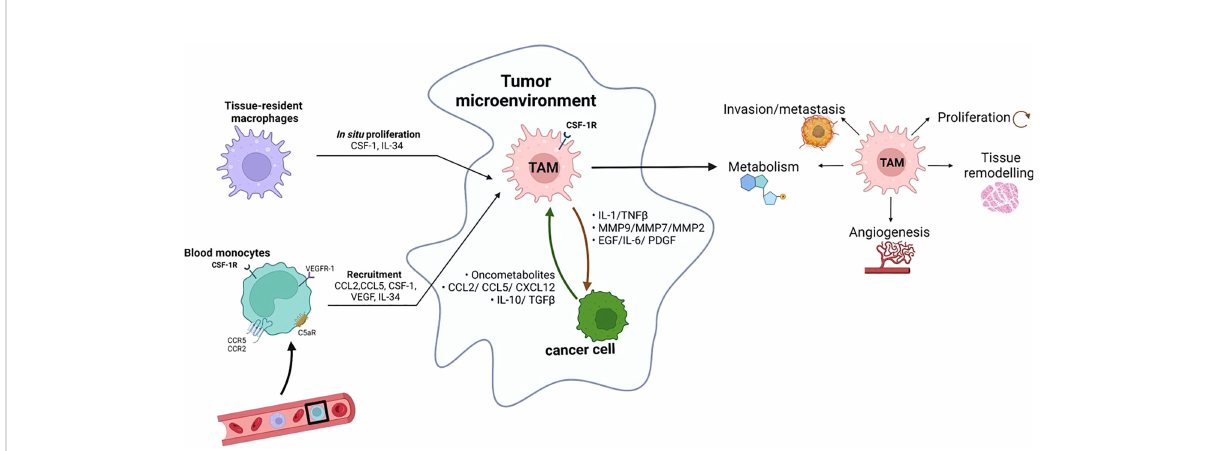
FIGURE 1 Monocytes in circulation can be recruited by tumors in response to different chemoattractants, including cytokines (such as CSF-1, VEGF and IL-34), chemokines (such as CCL2 and CCL5) and complement components (C5a). The tumor-in fi ltrating monocytes differentiate into TAMs. In some tumors, in situ proliferation can occur and tissue-resident macrophages can contribute to the TAM populations. TAMs in fl uence almost all aspects of tumor-cell biology, including cell proliferation, tissue remodeling, angiogenesis, metabolism, local invasion and metastasis (created with